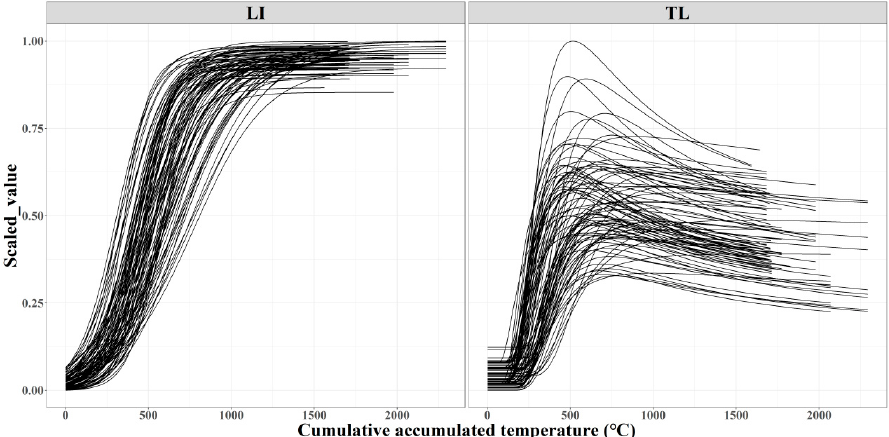
Figure 3. Simulation results of tillering and light interception dynamics of 91 cases.